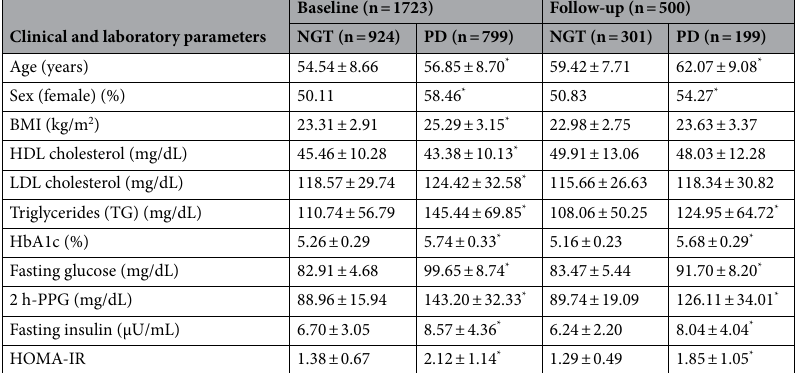
Table 1. Characteristics of the study populations in the baseline (KARE S2) and follow-up (KARE S5) cohorts by ADA criteria. Data presented as mean ± deviations (SD) and n (%). BMI body mass index, HDL high density lipoprotein, LDL low-density lipoprotein, HbA1c glycated hemoglobin. 2 h-PPG 2 h-postprandial glucose. HOMA-IR (homeostasis model assessment of insulin resistance) was calculated by following formula = [Fasting insulin (µlU/mL) × Fasting glucose (mg/dL)]/405. *Mann–Whitney test analyzed the significance between the two groups ( P <